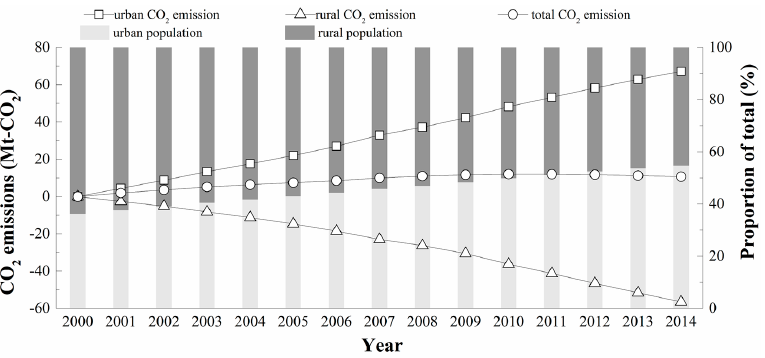
Figure 7. Accumulated changes in population structure effect on household CO 2 emissions and population structure in China (2000–2014).